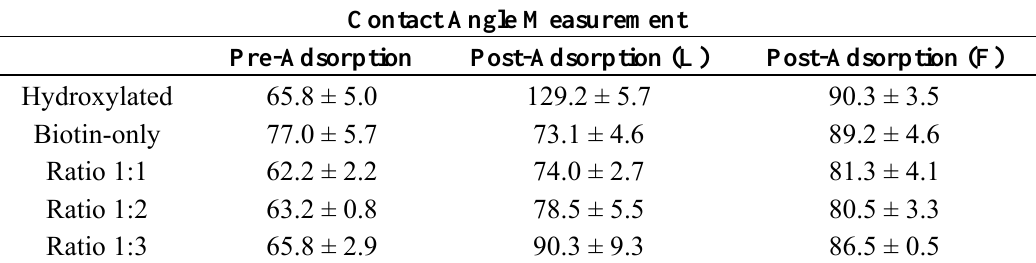
Table 1. Contact Angle Measurement before and after non-specific protein (Lysozyme and Fibrinogen) adsorption; the hydroxylated control experiences the largest increase in contact angle after adsorption, similar to the ellipsometry data, indicating that it experiences high adsorption, as